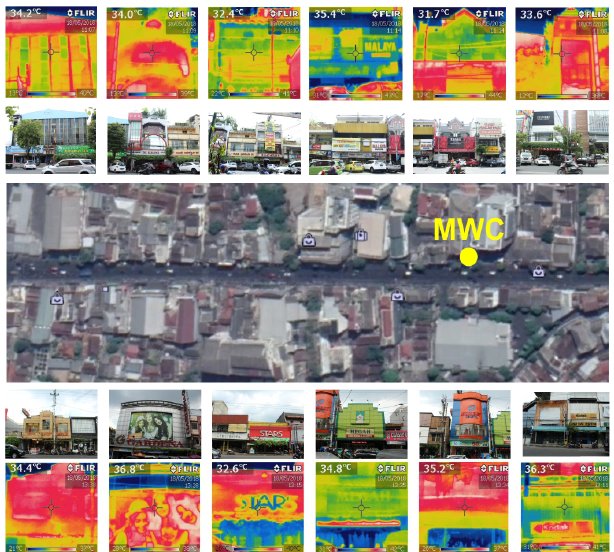
Fig. 3. Buildings’ facades along US Street and the thermal infrared images taken on 18 th May 2018 with the micro weather station (MWC) installed on the yellow